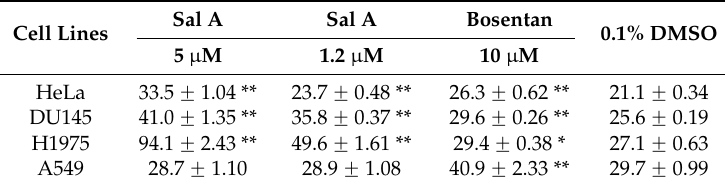
Table 2. The effect of Sal A on doubling time in different cell lines (h).